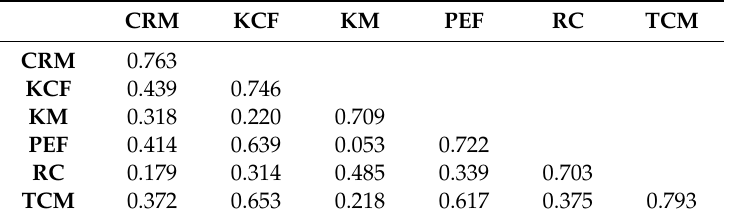
Table 3. The Fornell-Larcker criterion.